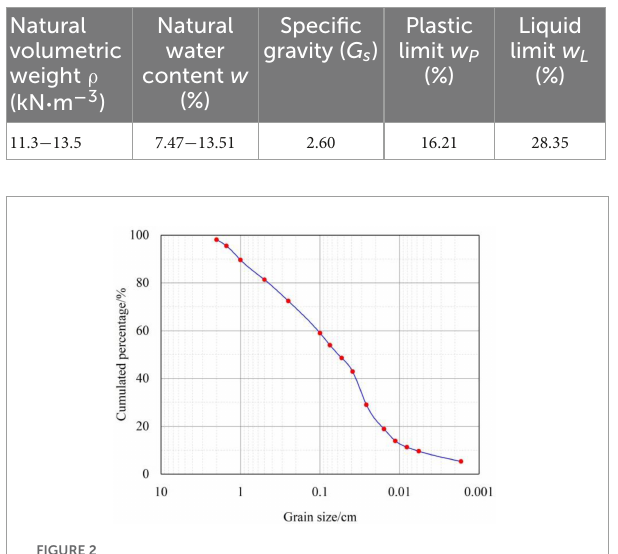
FIGURE2 The gradation curve of the experimental materials.